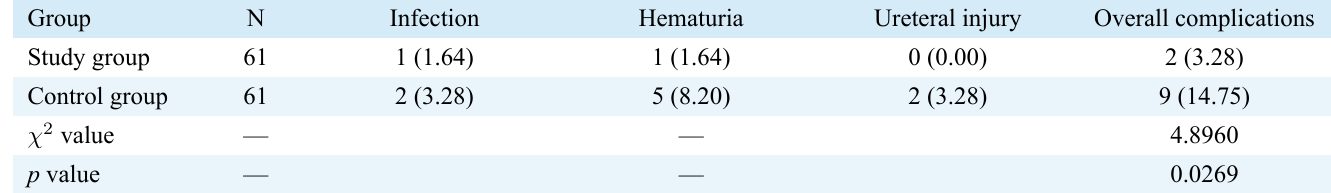
TABLE 4. Comparison of complications between study and control groups (n,